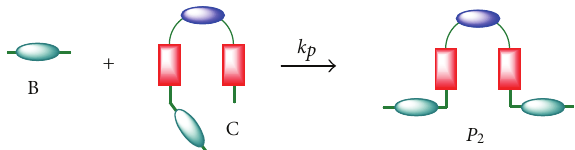
Scheme 7: Reaction scheme for kinetic model 4. Reaction of C with B to give P 2 .